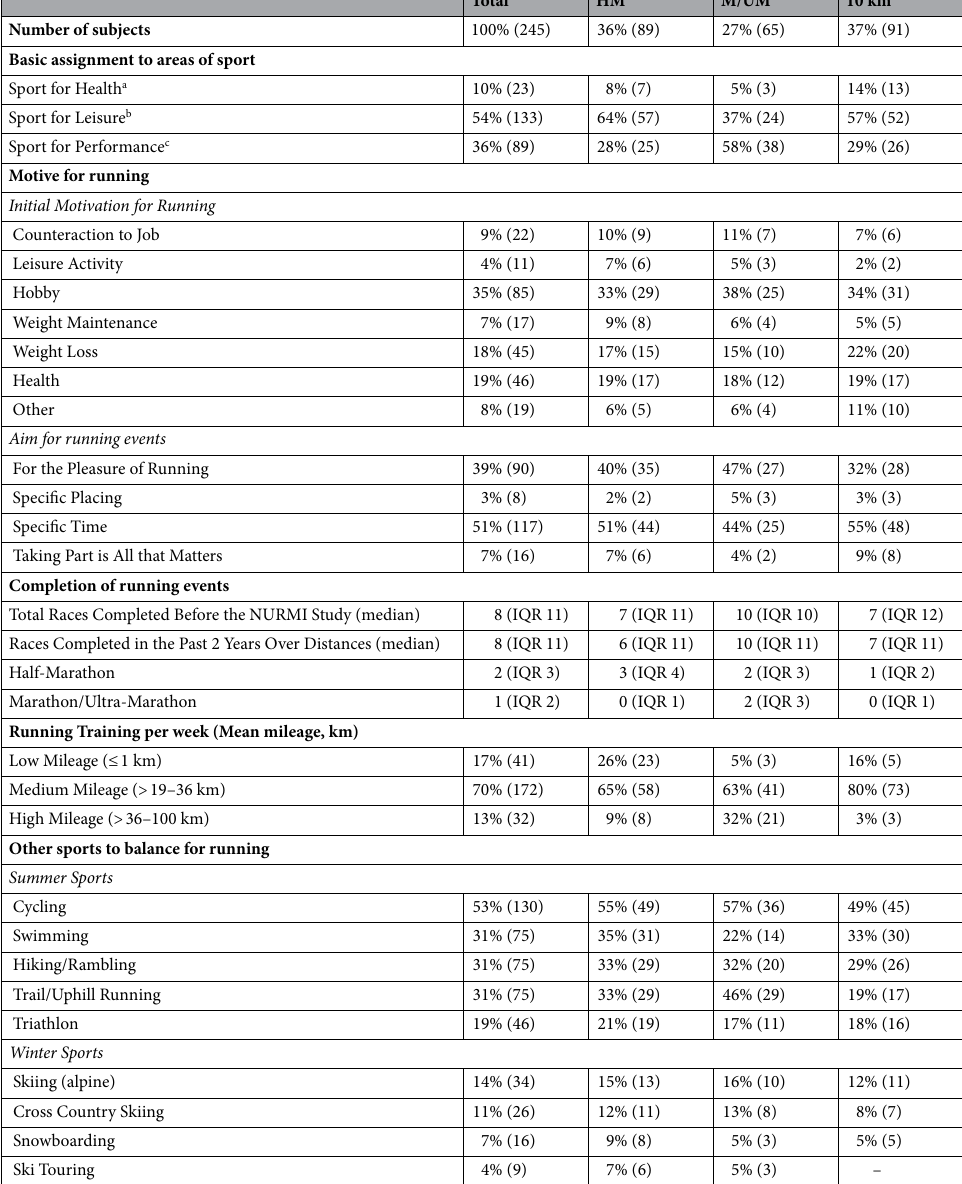
Table 2. Characteristics of running activity of the subjects. Data are presented as “percentage of prevalence (n)” or “median (IQR)”. HM half-marathon, IQR interquartile range, km kilometers, M/UM marathon/ultra- marathon. a Sport for health: Those who take part in sports for health reasons and train 2–3 times a week for 30–60 min at a low to moderate intensity with the aim of maintaining or improving their health. b Sport for leisure: Those who take part for leisure reasons and train 2–5 times a week for 60–90 min at a moderate intensity with the aim of enjoying their free time actively. c Sport for performance: Performance athletes train 3–6 times a week, at moderate to high intensities and assiduously follow a long-term training plan, including assessing their performance, with the aim of ascertaining and improving it and measuring it against that of other athletes in